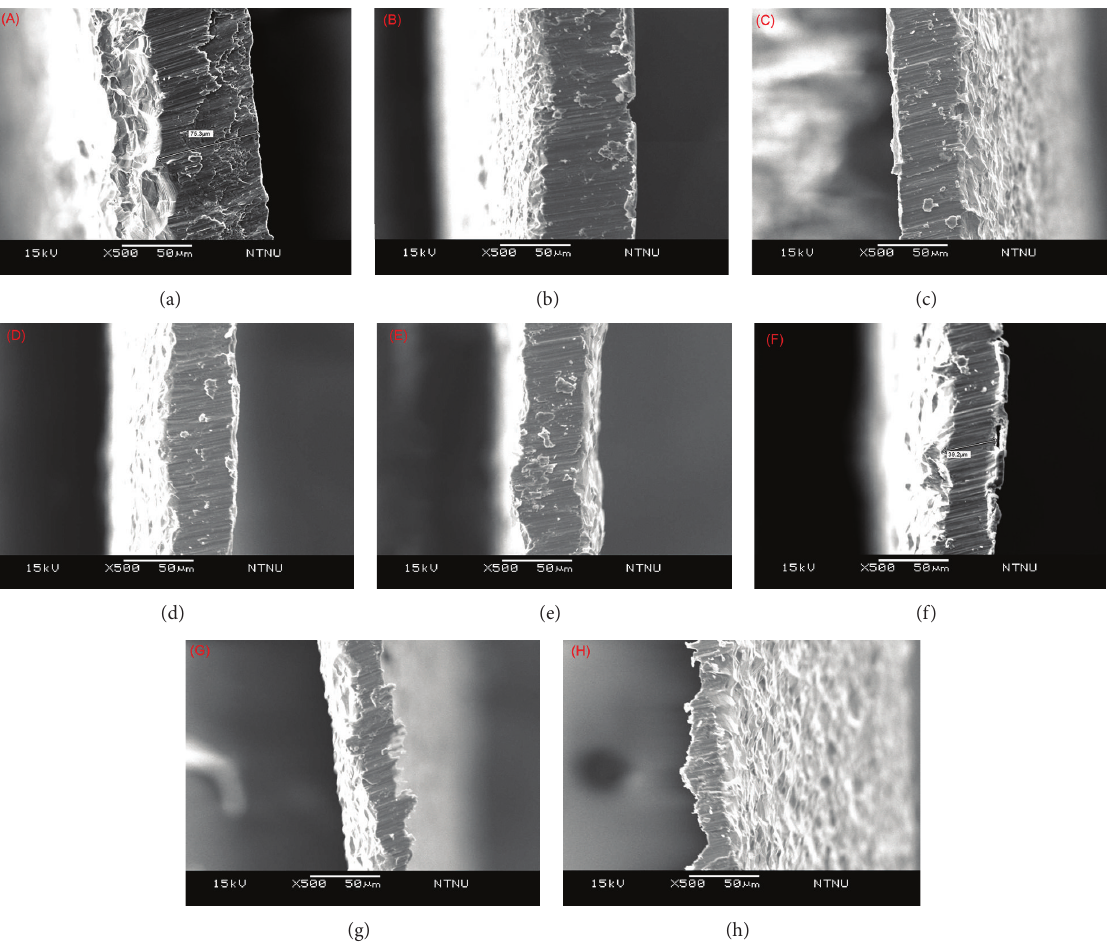
Figure 3: Cross-section morphologies of polishing-chemical etching under different times (a) 10min, (b) 11min, (c) 12 min, (d) 13min, (e) 14min, (f) 15 min, (g) 16min, and (h)